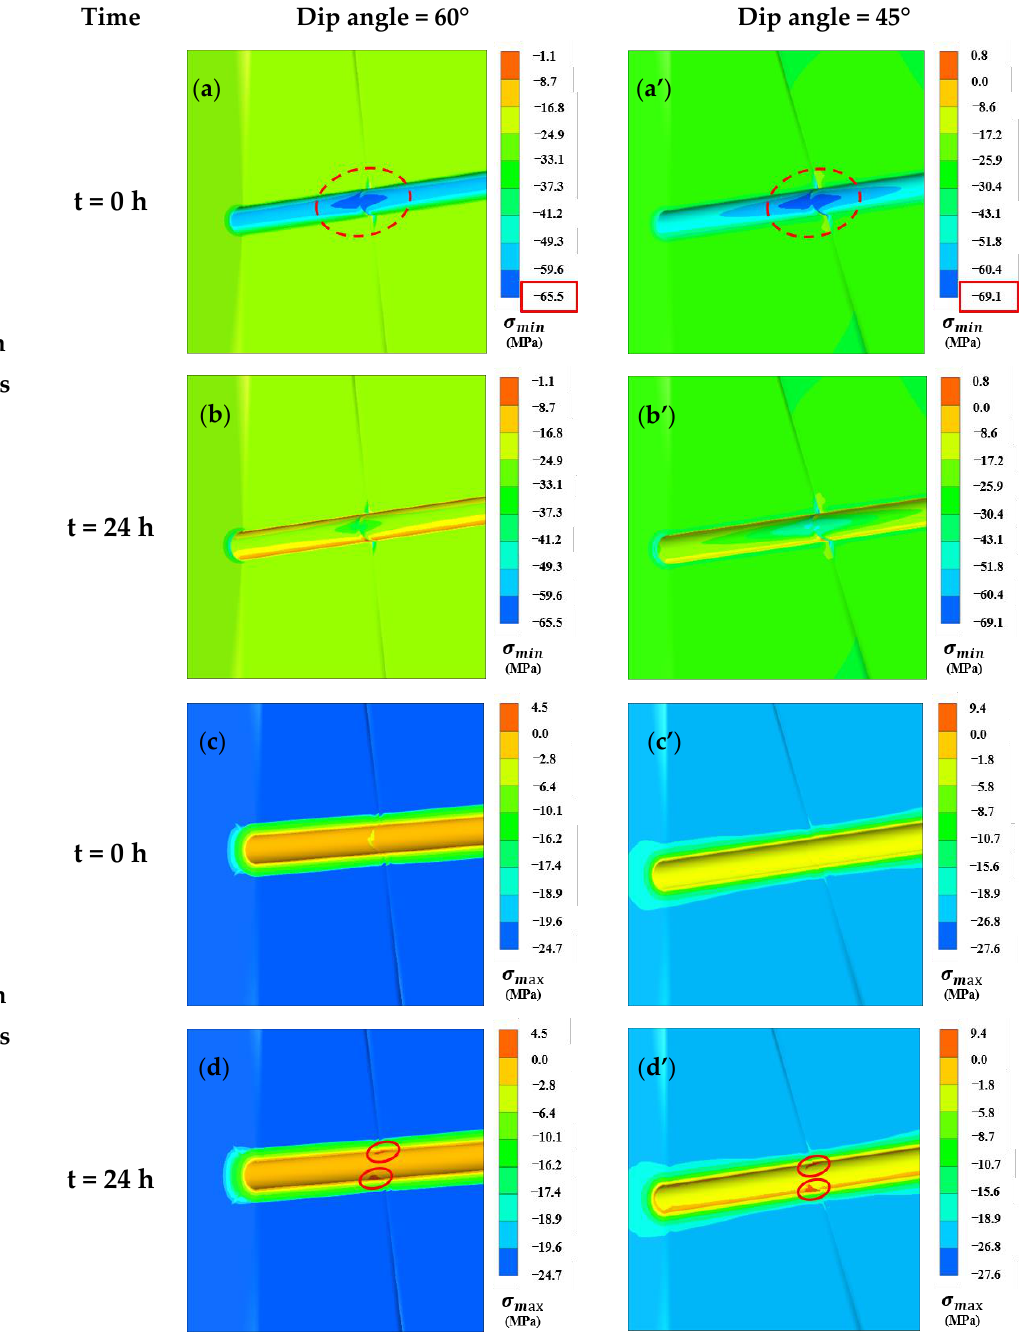
Figure 15. Distribution of the maximum and minimum principal stresses in the tunnel with a fault before and after cooling. ( a ) Minimum principal stress in the tunnel with a fault (Dip angle = 60°) when t = 0 h (The value in the red frame is the maximum of the minimum principal stress (compres- sive) and the location in red circle is stress concentration area). ( a’ ) Minimum principal stress in the tunnel with a fault (Dip angle = 45°) when t = 0 h (The value in the red frame is the maximum of the minimum principal stress (compressive) and the location in red circle is stress concentration area). ( b ) Minimum principal stress in the tunnel with a fault (Dip angle = 60°) when t = 24 h. ( b’ ) Minimum principal stress in the tunnel with a fault (Dip angle = 45°) when t = 24 h. ( c ) Maximum principal stress in the tunnel with a fault (Dip angle = 60°) when t = 0 h. ( c’ ) Maximum principal stress in the tunnel with a fault (Dip angle = 45°) when t = 0 h. ( d ) Maximum principal stress in the tunnel with a fault (Dip angle = 60°) when t = 24 h (The location in red circle is tensile stress area). ( d’ ) Maximum principal stress in the tunnel with a fault (Dip angle = 45°) when t = 24 h (The location in red circle is tensile stress area).